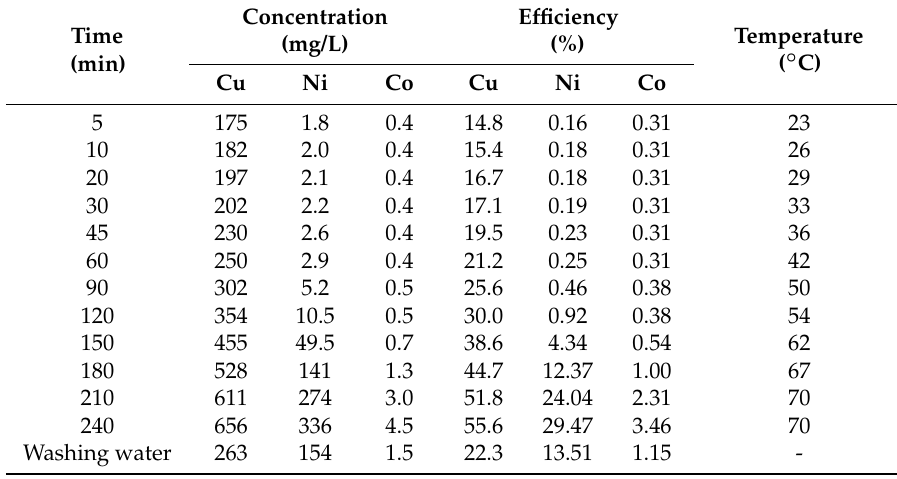
Table 10. Metals concentration and extraction efficiency of ammoniacal leaching with ultrasound and microwave (30 W).